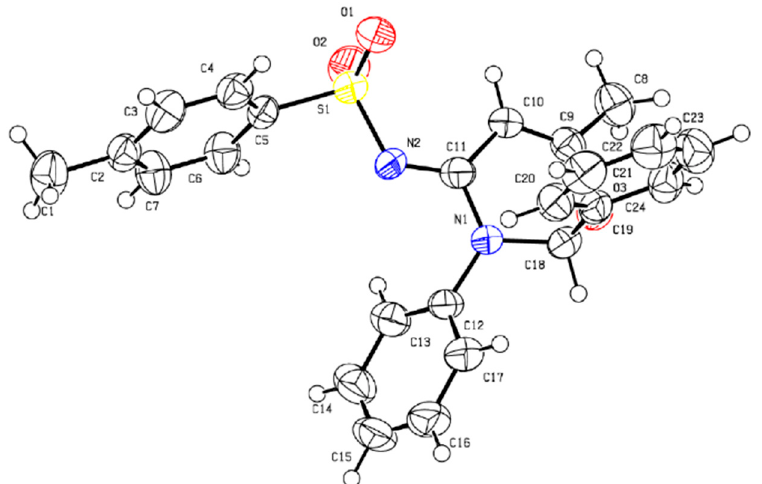
Figure 2. X-ray crystal structure of compound 4a .